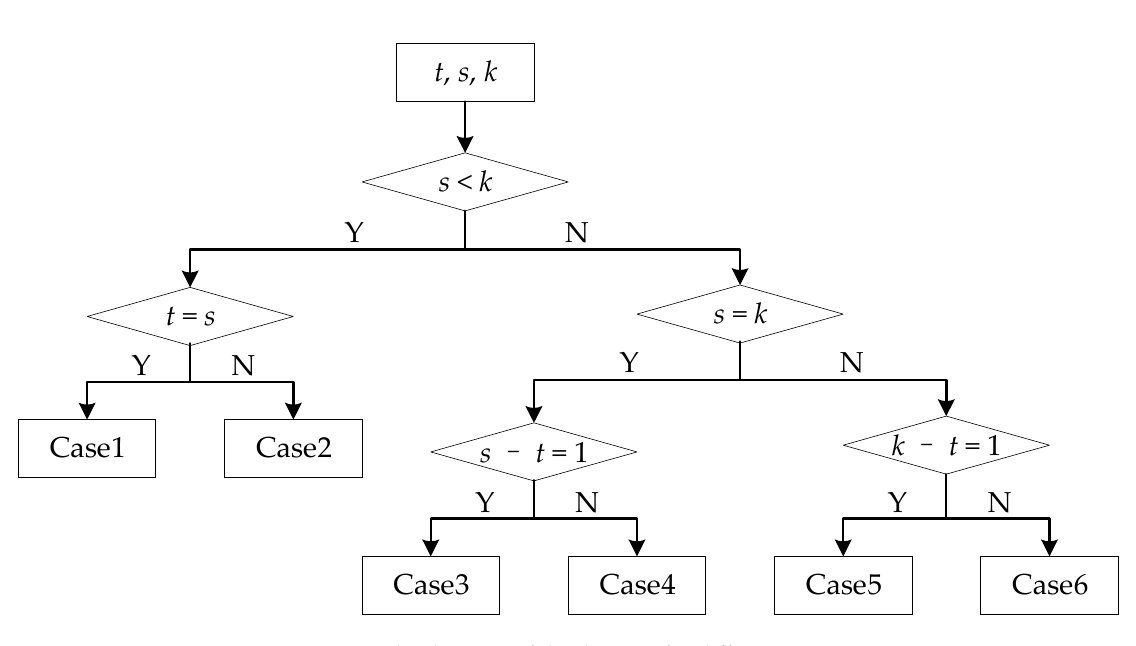
Figure 4. The diagram of the division for different cases.